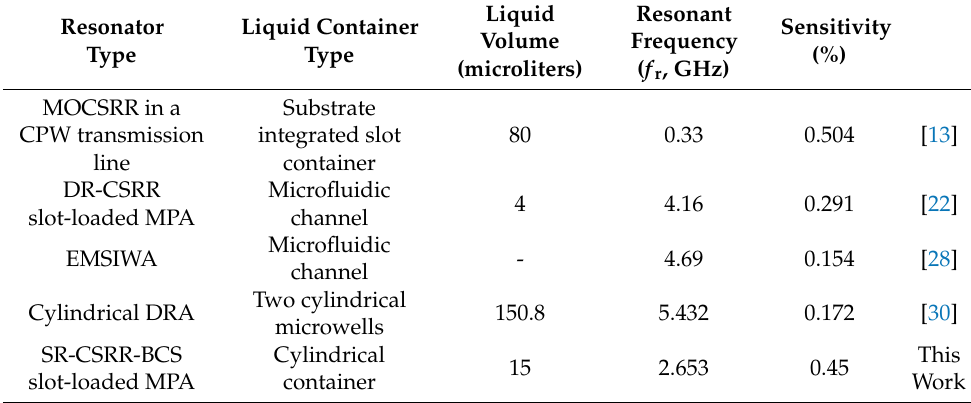
Table 4. Sensitivity (%) comparison with other microwave sensors in the